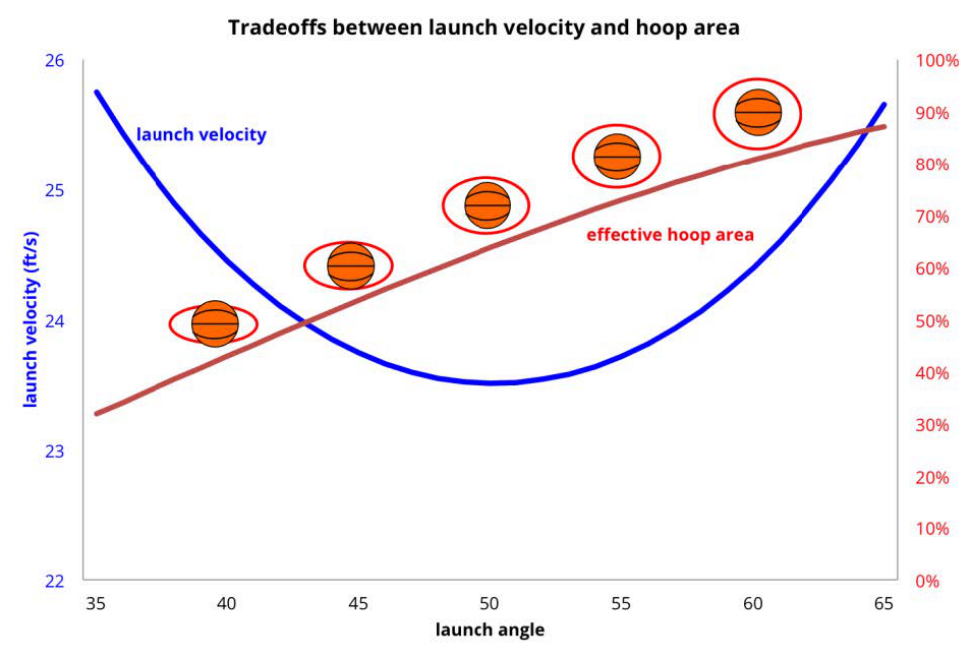
Fig. 3 The change curve of height with shot